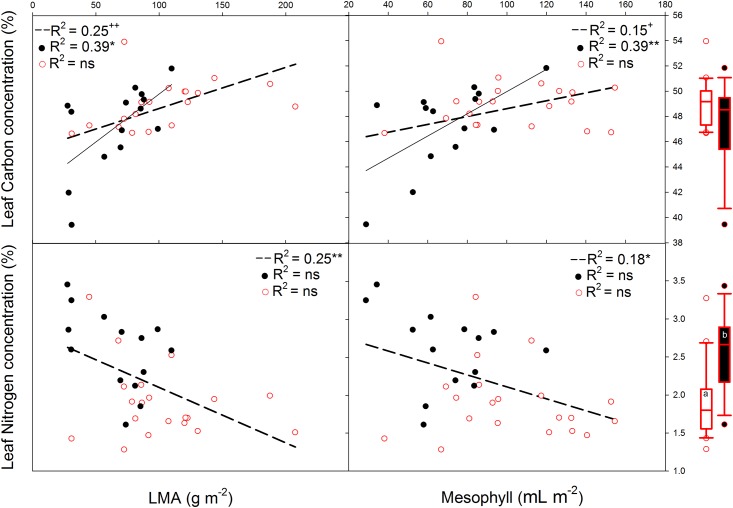
A) Linear regressions of leaf mass area (LMA) and mesophyll with leaf carbon concentration (LCC) and leaf nitrogen concentration (LNC), for deciduous species (dark line and circles), evergreens (red line and empty red circles) and all the species (dashed line). In brackets the slopes of the regression lines are given. The level of significance is expressed as follows: * P < 0.05, ** P < 0.01, *** P < 0.001, + is shown when the relationship is phylogenetically dependent. Box plots (median and 1st and 3rd quartiles) of deciduous vs. evergreen species are included in the margins; the significant results are based on the phylogenetic generalised least squares model (PGLS). The results based on PGLS can be found in S3 Table, Supporting Information. Whiskers show the minimum and maximum values that fall within 1.5x the length of the box away from the interquartile range; data further away are shown as outliers.